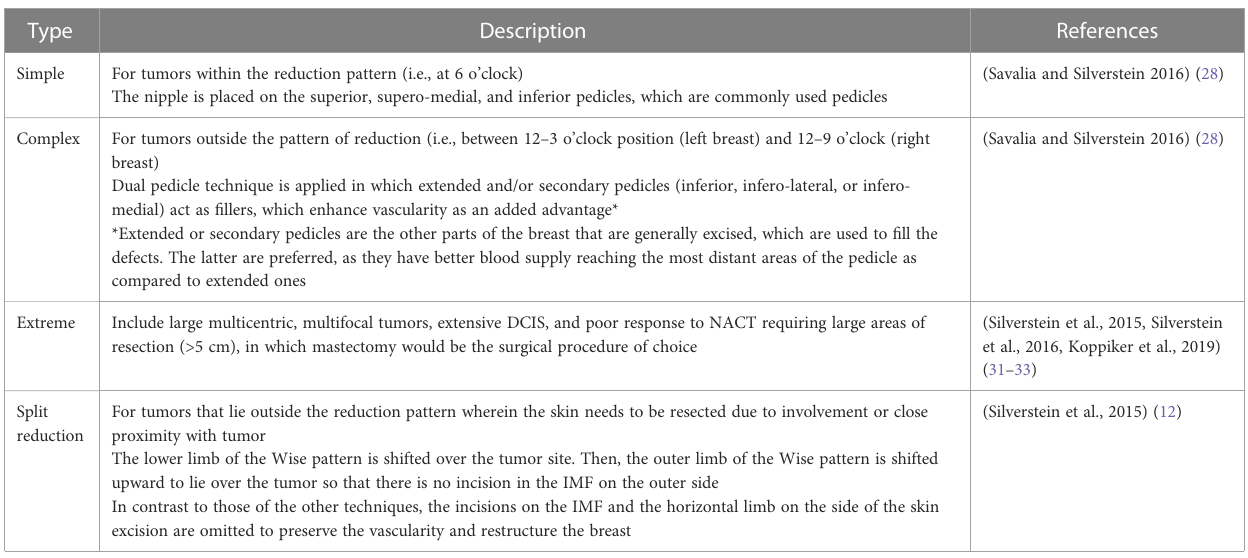
TABLE 1 Classi fi cation of TM